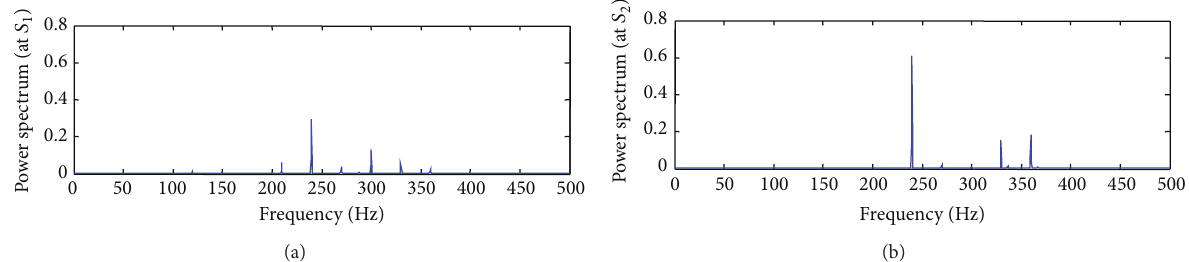
Figure 5: Power spectrums in a healthy condition: (a) measured at 𝑆 1 and (b) measured at 𝑆 2 .